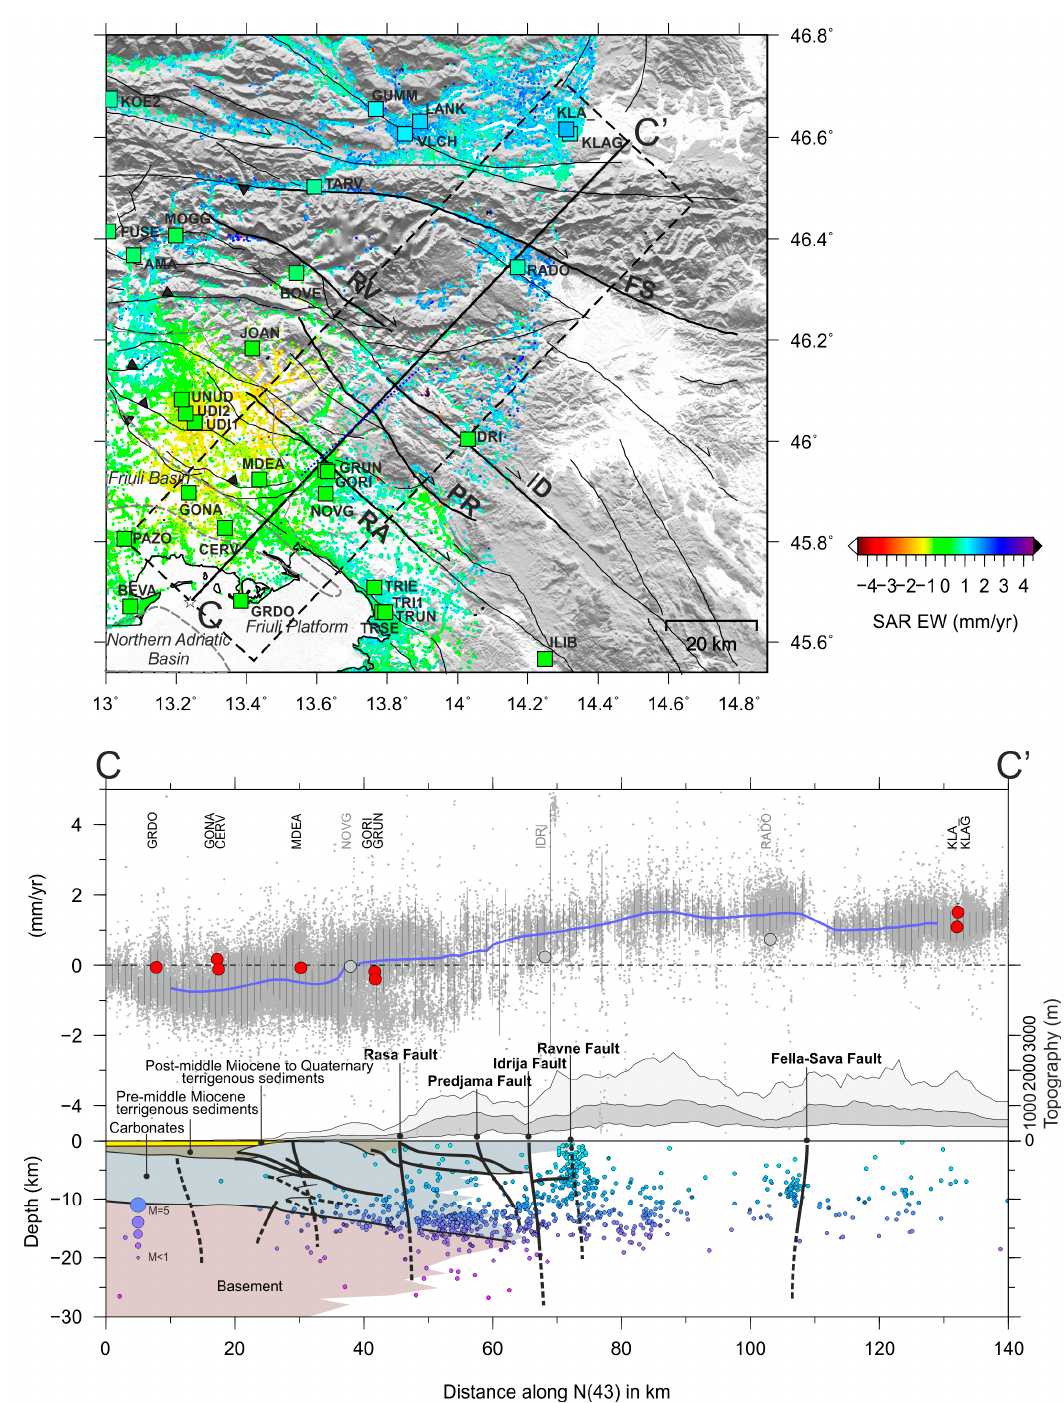
Figure 10. East–west velocity profile across the Dinaric system. Top : the map shows the east–west velocity values for each PS, while the colored squares indicate the east–west velocity of the GNSS stations, according to the InSAR multicolor scale on the right (red = westward; blue = eastward displacement). The blue dotted line represents the trace of the geological section reported below. The profile with a buffer of 20 km) is 140 km long, and the white star indicates the starting point. Bottom : the plot shows the east–west InSAR velocities (grey dots), whereas the blue line indicates the median value. The circles with relative uncertainties represent the east–west velocities of GNSS stations; specifically, the grey ones have not been used during the calibration. The geological section is modified from Moulin et al. [56].